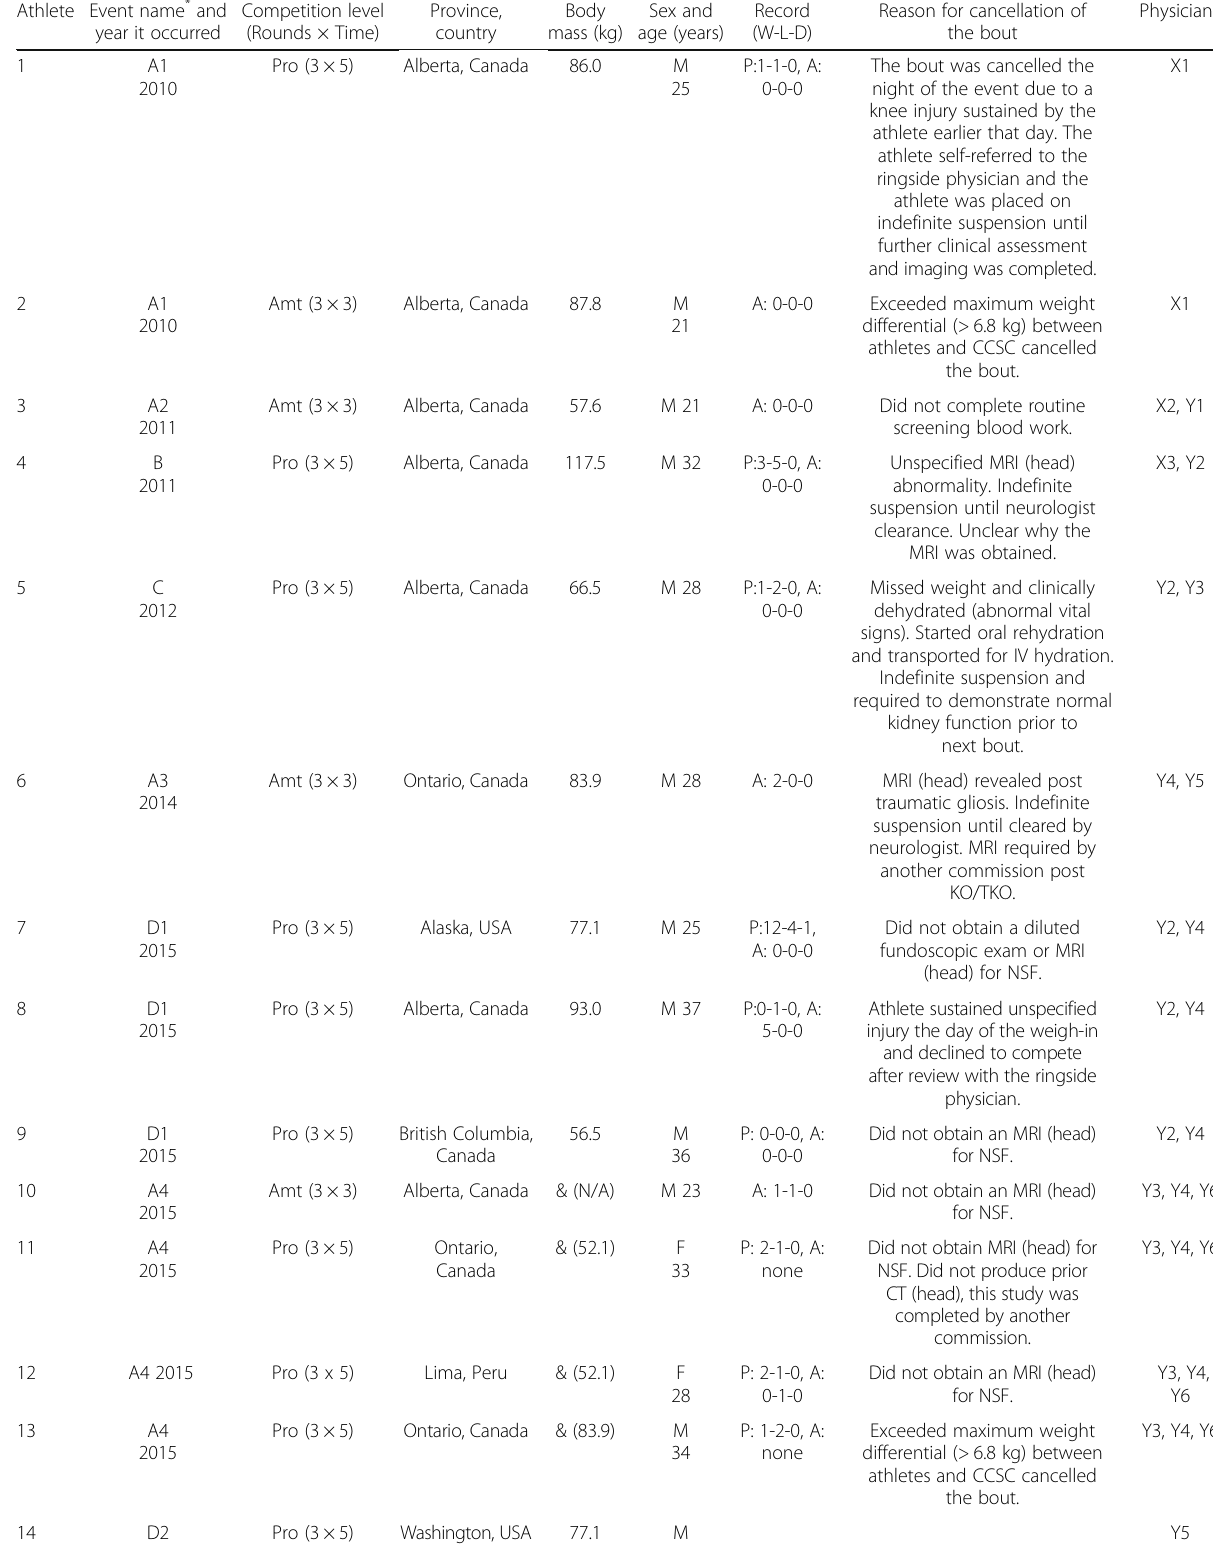
Table 1 Medical reasons and characteristics of athletes involved in cancelled bouts in Calgary, Alberta, from January 2010 – December